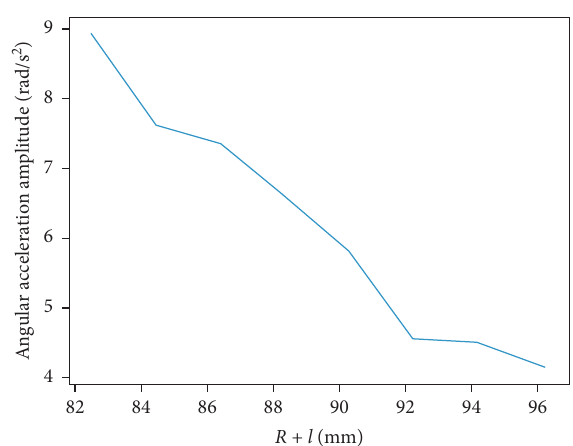
Figure 19: Variationinangular accelerationamplitudeof J